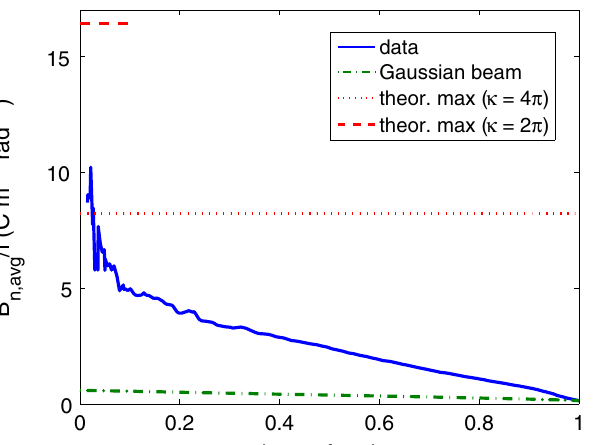
FIG. 22. (Color) Beam brightness normalized per single bunch as a function of contributing beam fraction for 80 pC charge per bunch. Corresponding result for an equivalent Gaussian beam with the same 100% rms emittance is shown for comparison (dot-dashed line). Dotted and dashed lines show the theoretical limit as given by Eq. (5) for (cid:7) ¼ 4 (cid:8) and 2 (cid:8) , respectively. The rms normalized emittance is 1 : 8 (cid:2) 0 : 2 (cid:1) m .